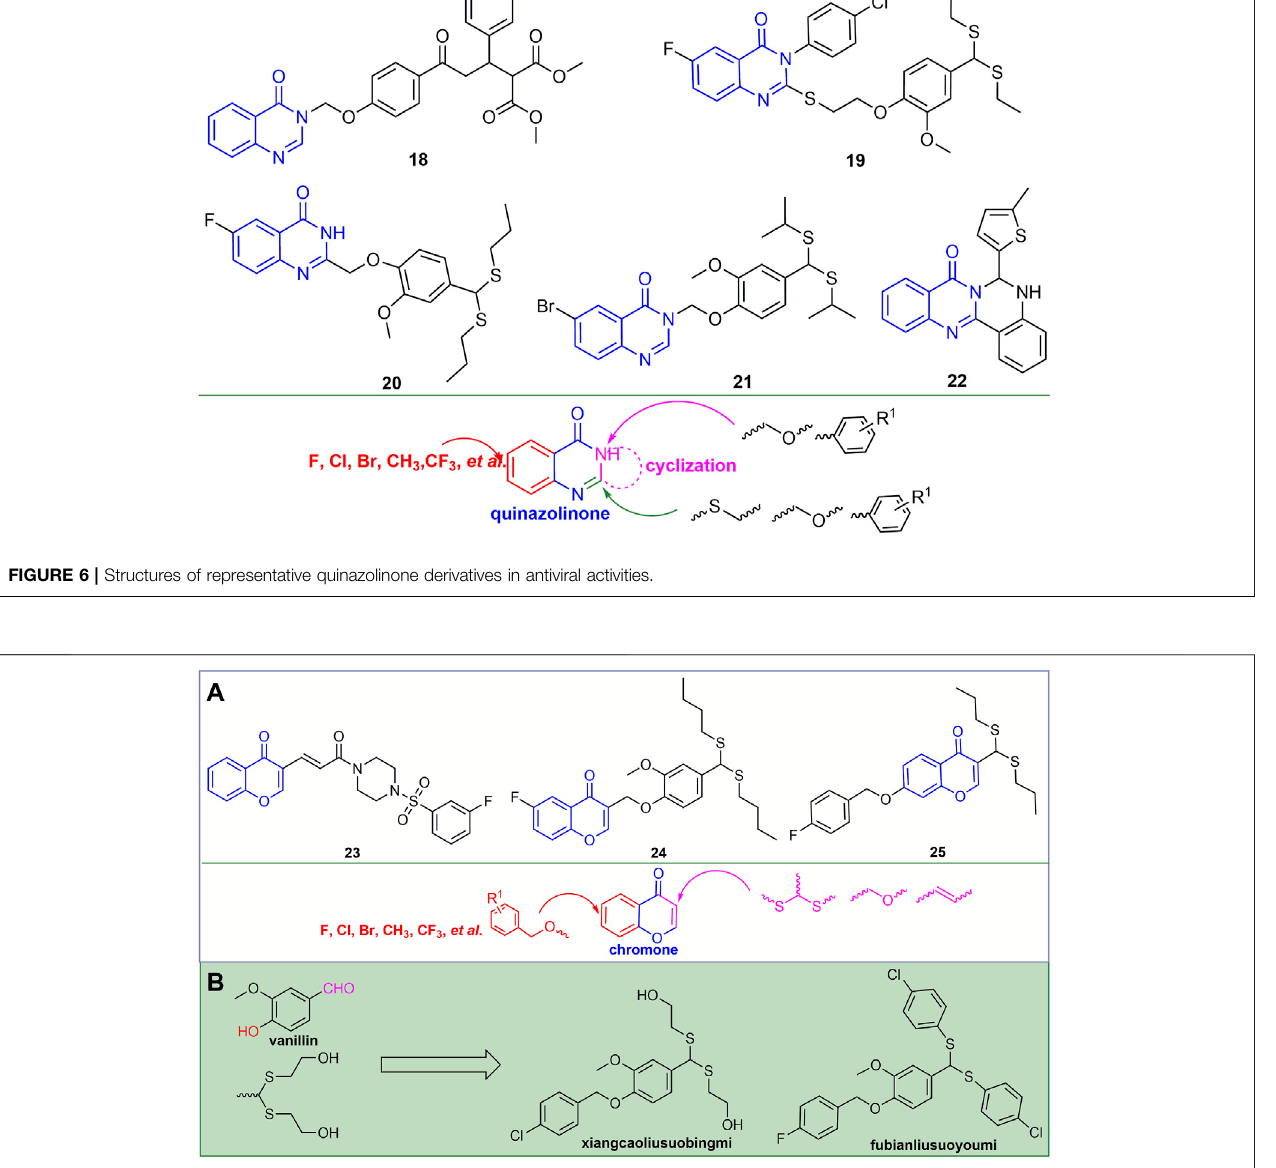
Frontiers in Chemistry |